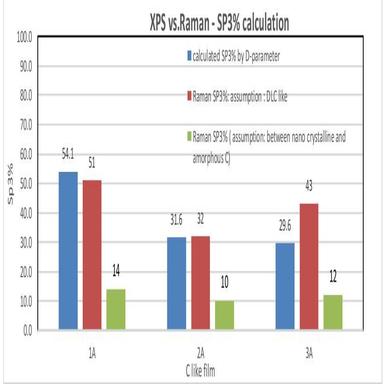
SP3% calculated in Set 1 films by XPS and Raman.